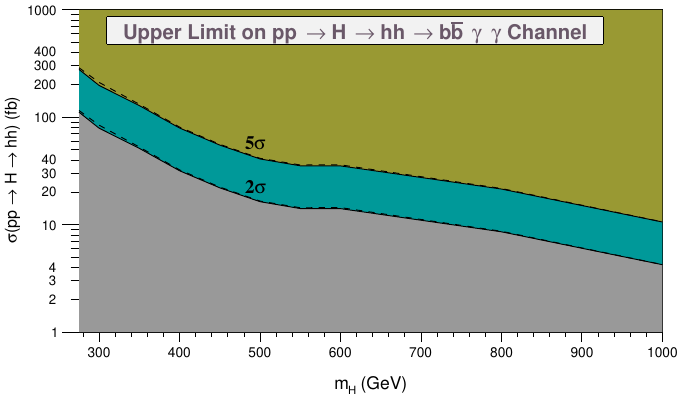
Table 4 . The cut-(cid:13)ow table for heavy Higgs of mass 400 GeV. The table also shows the various perturbative orders at which the cross-sections have been used.